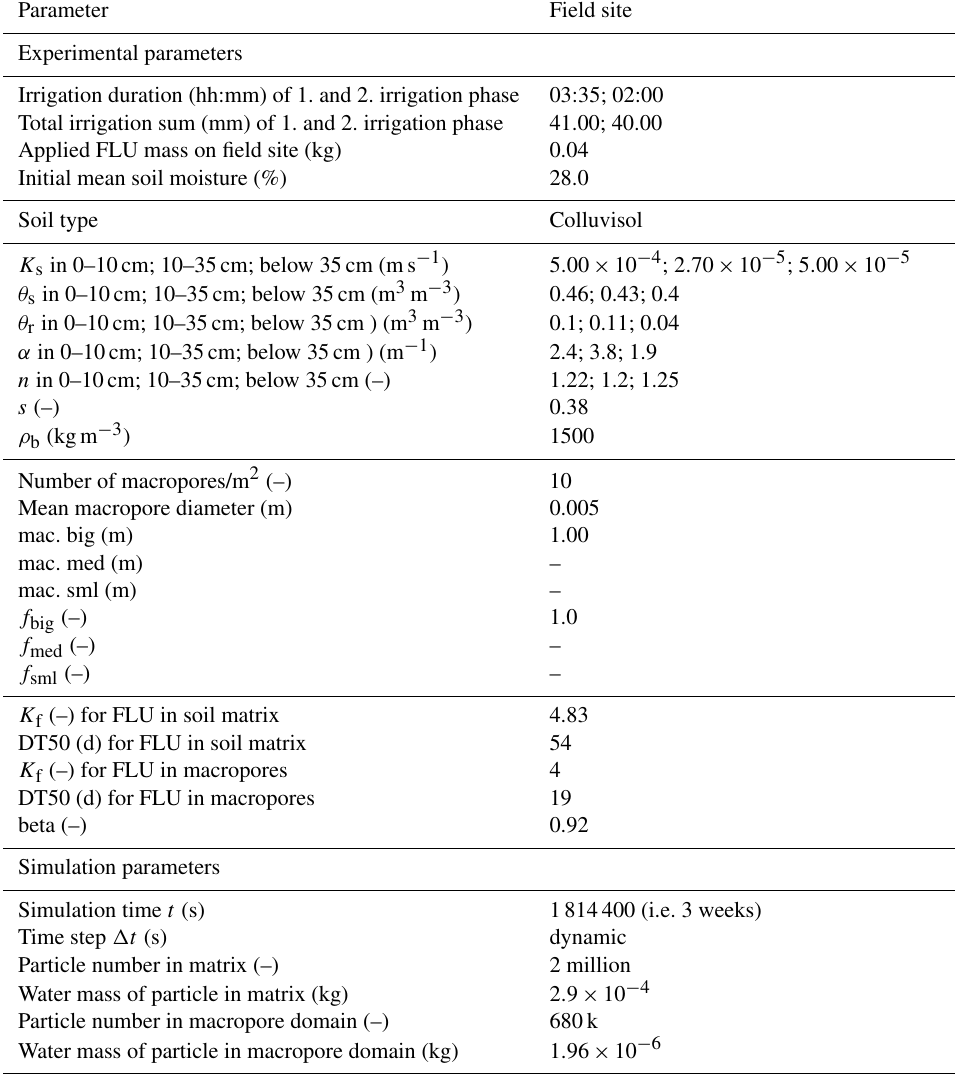
Table 4. Parameters of field-scale FLU breakthrough experiment (Klaus et al., 2014) and simulation parameters as well as soil hydraulic parameters after van Genuchten (1980) and Mualem (1976). For parameter definitions and further details on these parameters, see caption of Table 1 and Sternagel et al. (2019). Note that only one macropore depth of 1m reaching the depth of the tile-drain tube is